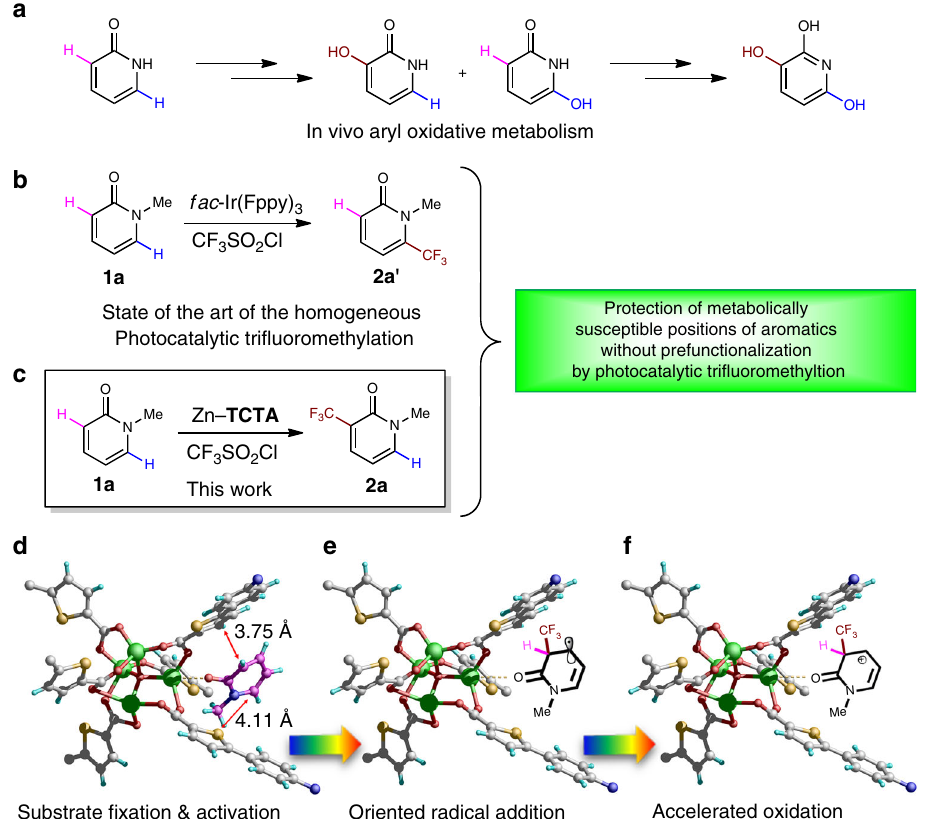
Fig. 3 Schematic illustration of the photocatalytic site-speci fi c tri fl uoromethylaion. a Potential reaction paths of the in vivo enzymatic aryl oxidative metabolism of (2 H )-pyridone. Complementary approaches to the protection of metabolically susceptible sites by tri fl uoromethylation using b fac -Ir(Fppy) 3 or c Zn – TCTA as the photocatalyst, respectively. d Crystal structure of 1a @Zn – TCTA showing the multiple interactions between 1a and the Zn – TCTA scaffold and the potential reaction paths e and f for the